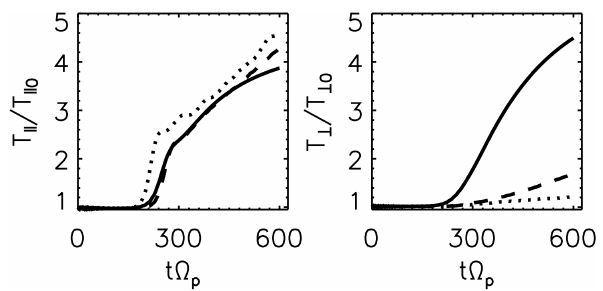
Figure 5. Time evolution of the parallel ( T (cid:107) ) and perpendicular ( T ⊥ ) proton temperatures. The dashed and dotted lines represent the result obtained from downgraded 2-D and 1-D configurations. The temperatures are normalized to their initial